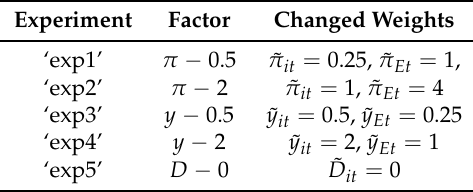
Table 9. Robustness check experiments.